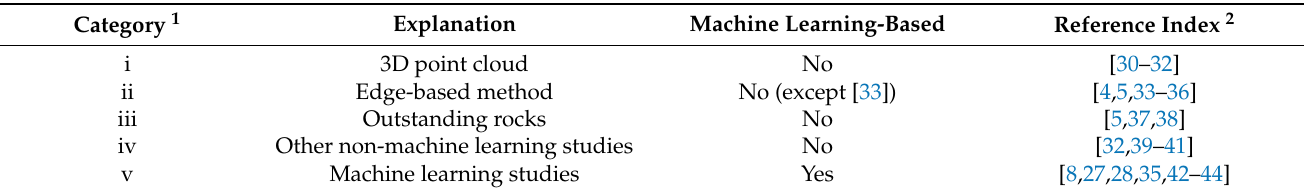
Table 1. The summary of the related studies on rock segmentation for planetary